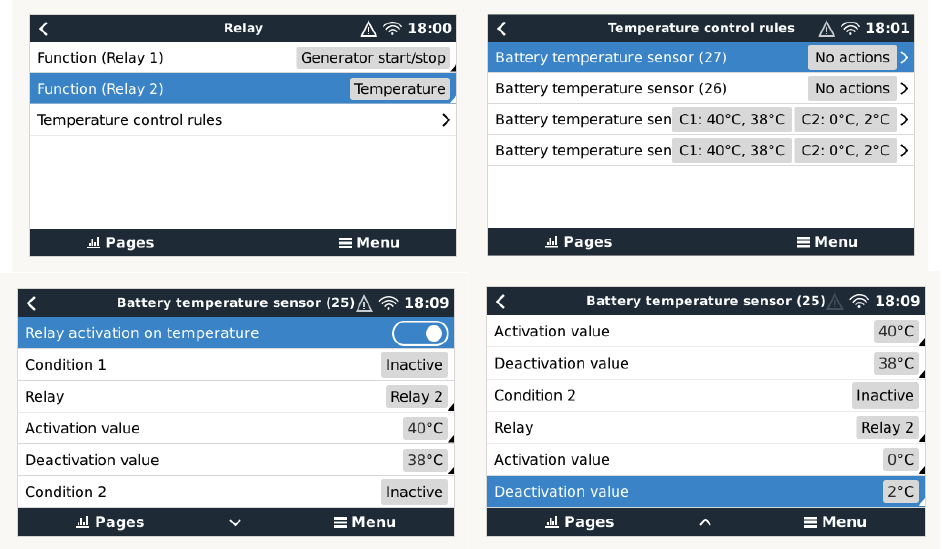
Figure 20. Condition configuration based on Temperature Sensors 24 and 25 and Cerbo GX Relay 2.